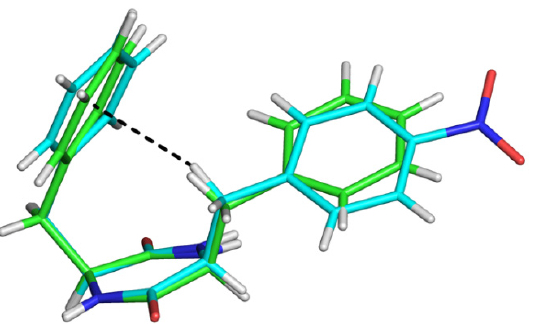
Figure 3. Superimposition of the single-crystal XRD structures of cyclo(Phe-Phe) (green carbon atoms) and cyclo(p-nitro-Phe-Phe) (cyan carbon atoms) reveal the same conformation with an intramolecular CH- π interaction (dashed line). Nitrogen, oxygen, and hydrogen atoms are colored in blue, red, and white, respectively. Reproduced with permission from [86], Copyright © 2019, Thieme Verlag, Germany.